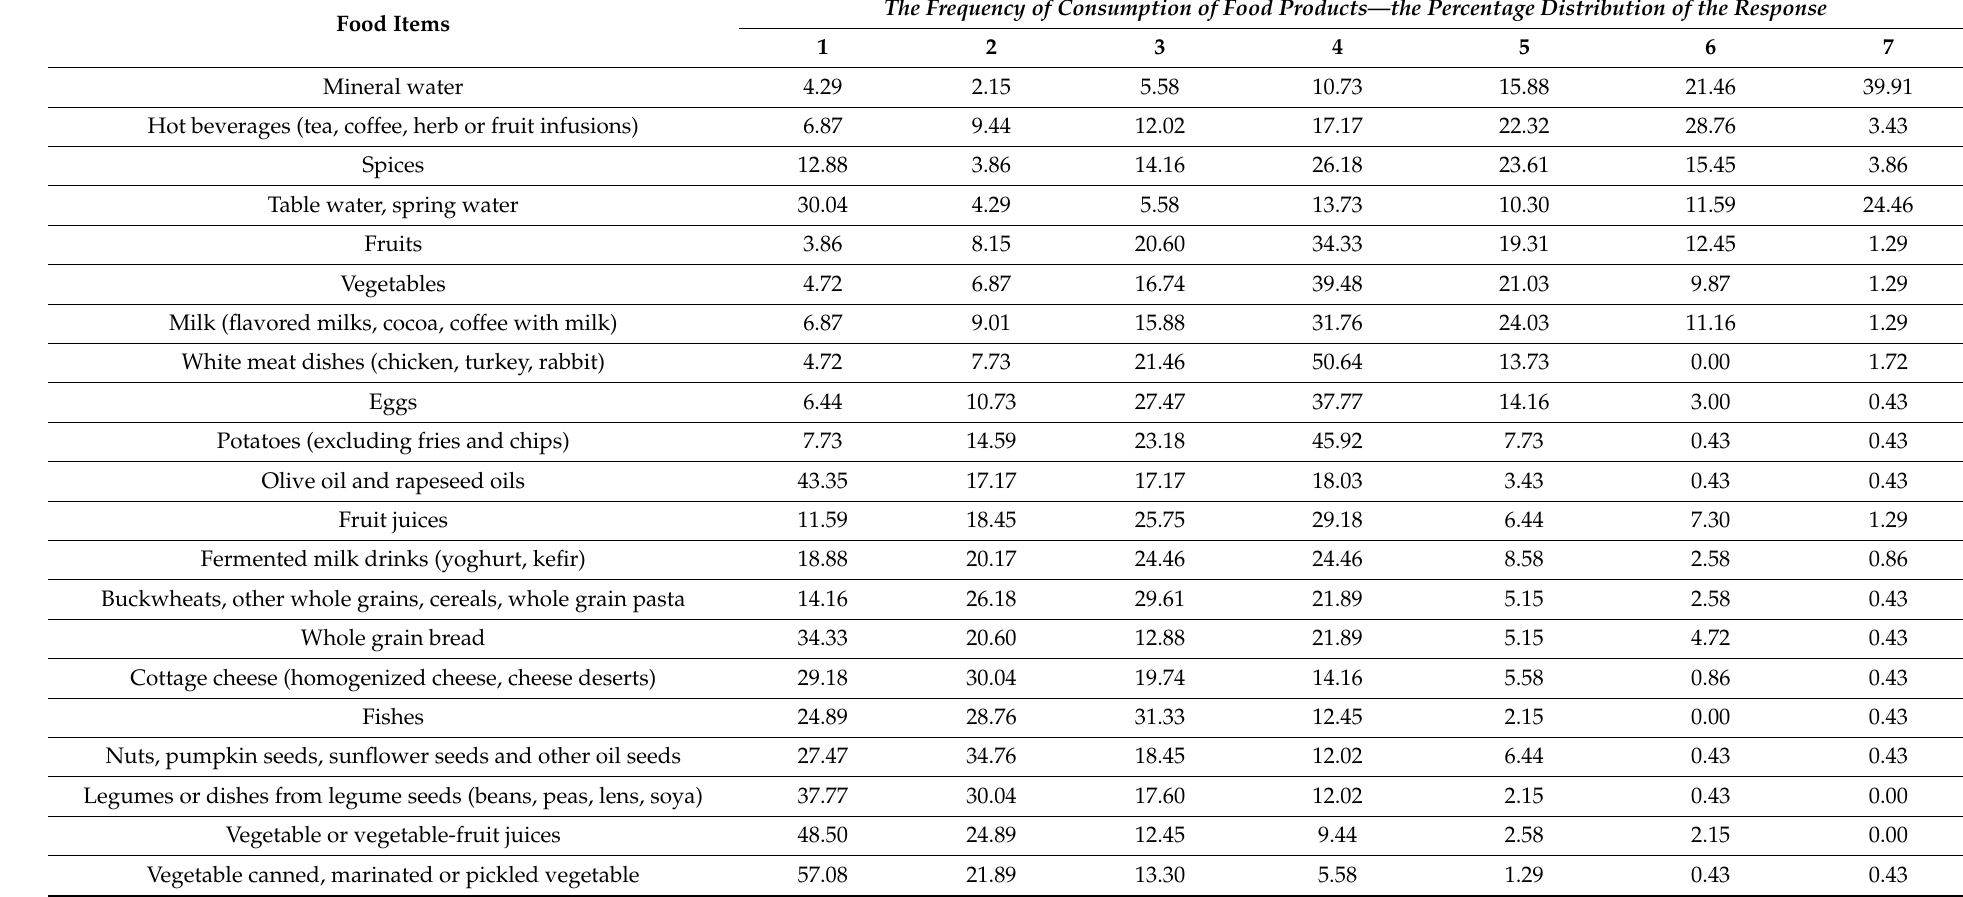
Table A2. The frequency of food items consumption positively influences brain function—The distribution of